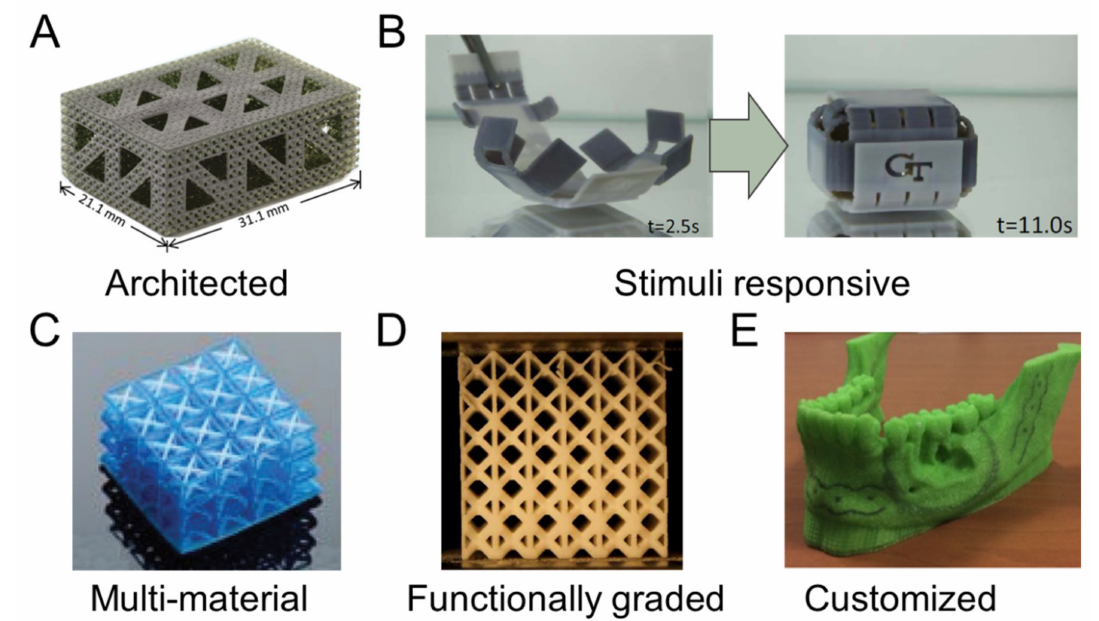
Figure 4. Design strategies including a (A) hierarchical architected lattice [14], ( B ) thermo-responsive container [15], ( C ) multi-material structure [69], ( D ) functionally graded lattice [70], and ( E ) customized mandible template [71]. Images adapted with